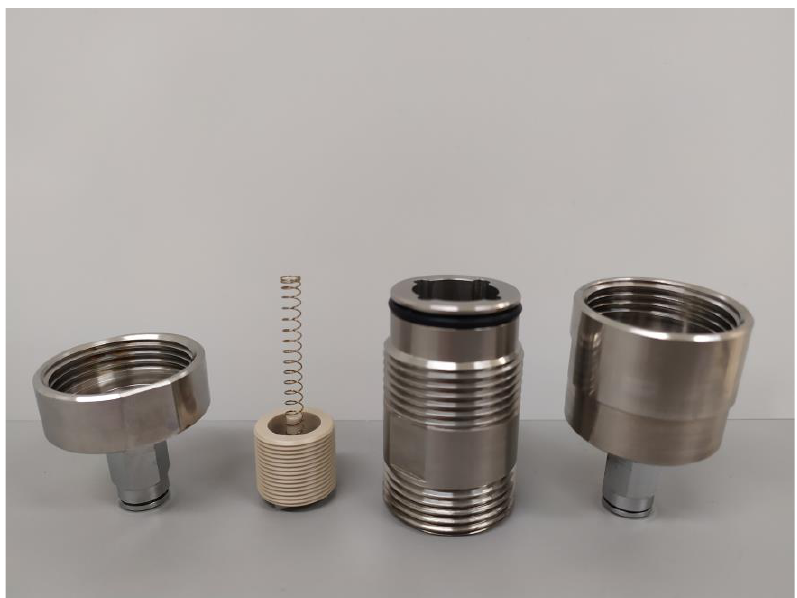
Figure 5. Prototype teardown showing, from left to right: the inlet flange, the piston, and the spring, the cylinder, and the outlet flange. Nominal dimensions are provided in the mechanical drawings. The height of the piston made of PEEK is 2 mm shorter than expected and the clearance between the piston and the cylinder is larger than expected (inner diameter of the cylinder at 18.035 mm instead of 18.015 mm); the other parts are within specification.